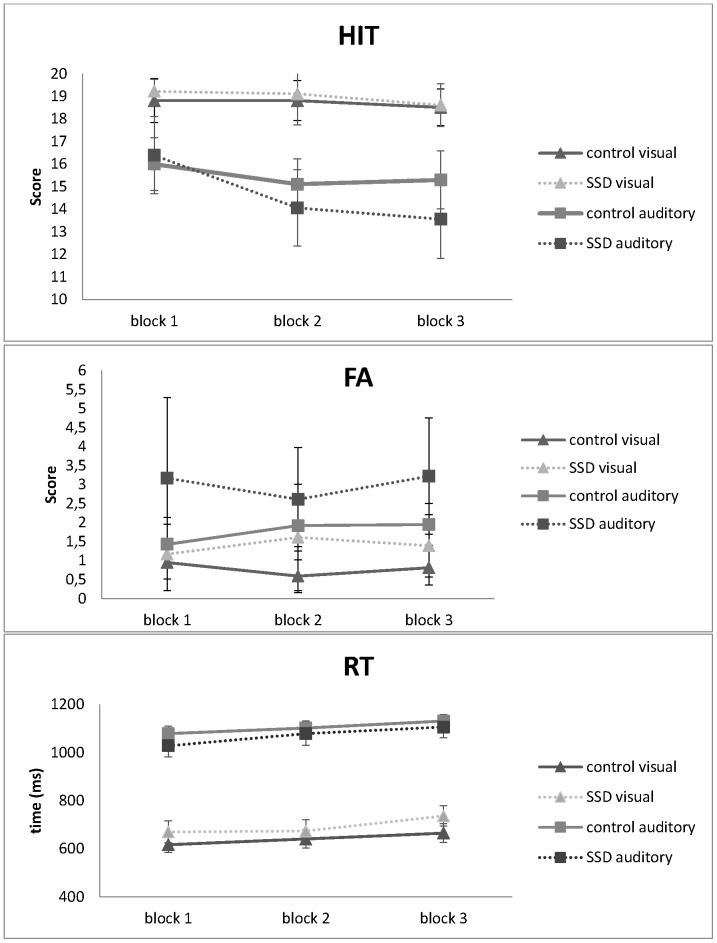
Performance along blocks for both groups.FA (false alarm); RT (response time).